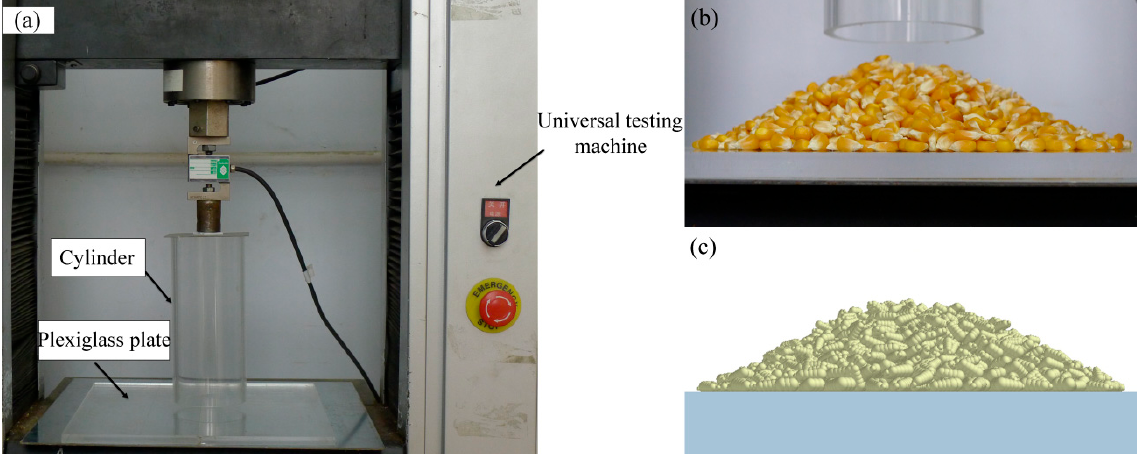
Figure 14. Schematic of the lifting cylinder test: ( a ) apparatus of the lifting cylinder test, ( b ) experimental result of the lifting cylinder test and ( c ) simulation result of the lifting cylinder test.